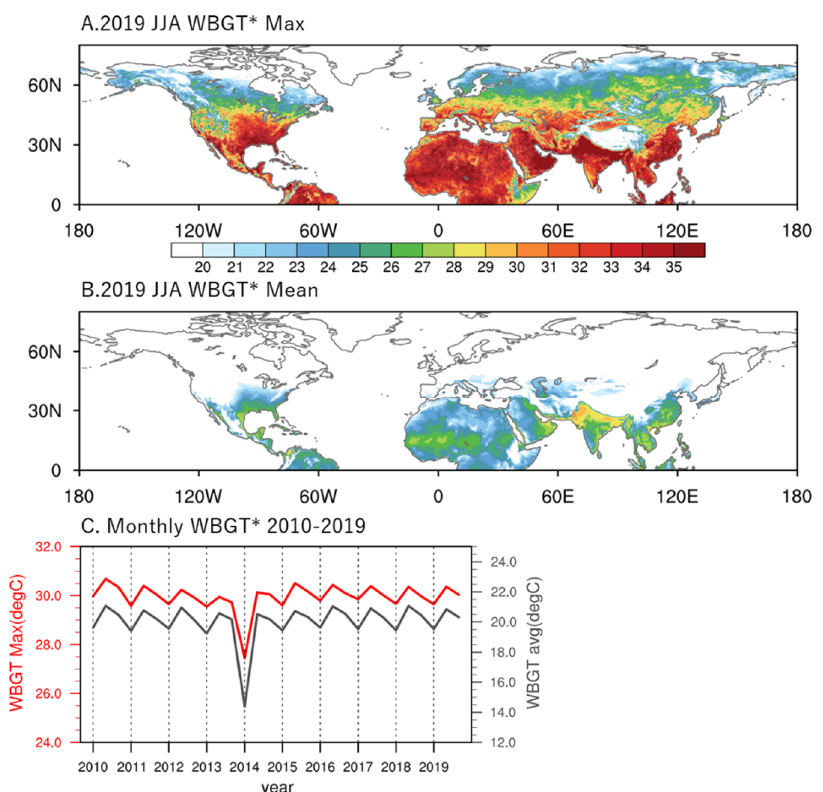
Figure 1. ( A ) Summer (June–August) averaged maximum WBGT* (°C) for the northern hemisphere in 2019. ( B ) Same as in ( A ), except for mean WBGT*. ( C ) Northern hemisphere land-only summer monthly averaged mean and maximum WBGT* during 2010–2019. The mean and max values showing in the figure are 50 and 98 percentiles, respectively, of the WBGT* data range.